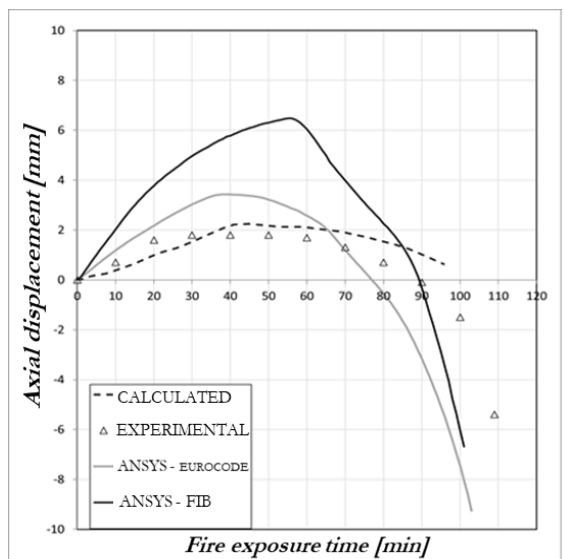
Figure 12. Comparison of Column 3 axial